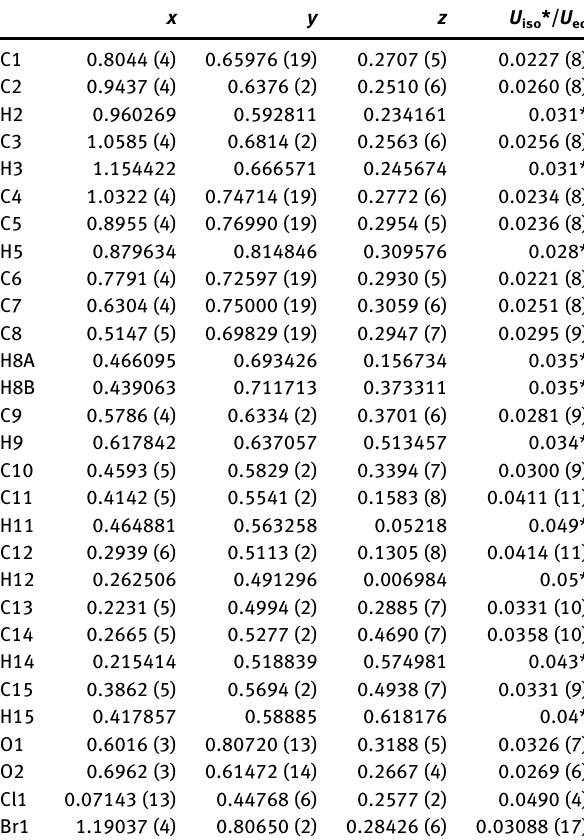
Table  : Fractional atomic coordinates and isotropic or equivalent isotropic displacement parameters (Å 